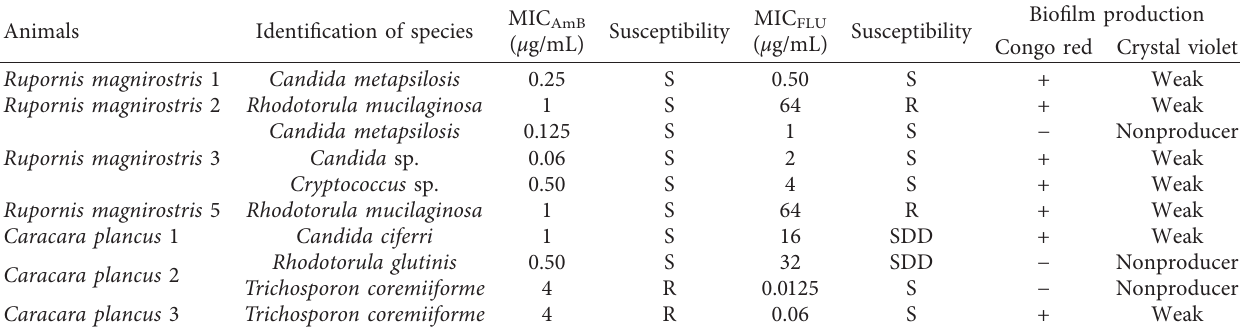
Table 3: Resistance profile and biofilm production of yeasts isolated from oropharynx of Rupornis magnirostris and Caracara plancus . Animals Identification of